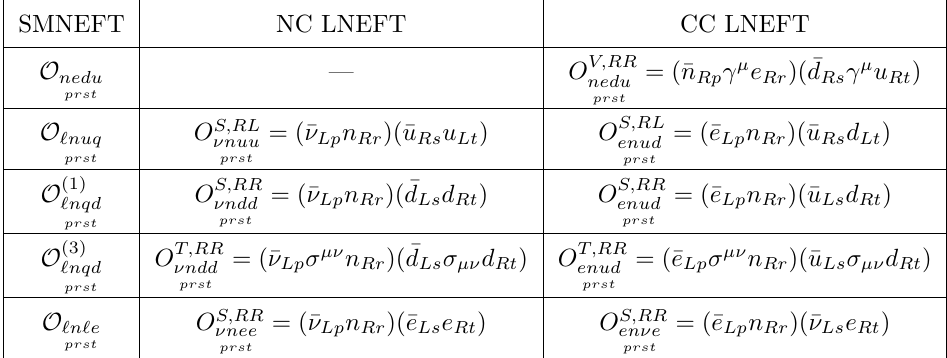
Table 2 . Operator structure matching between SMNEFT and